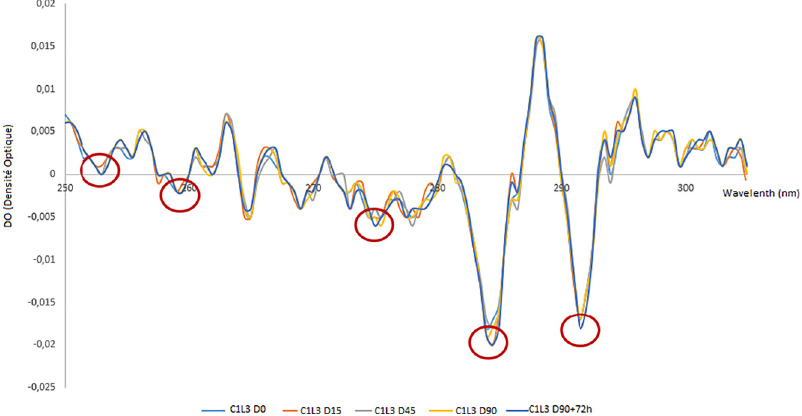
Figure1: SecondderivativeUVspectrumofBevacizumabdilutedto1.4mg/mLandstoredinabagat + 4 ° C:Nomodi fi cationisobserved(absenceofshift greater than 1